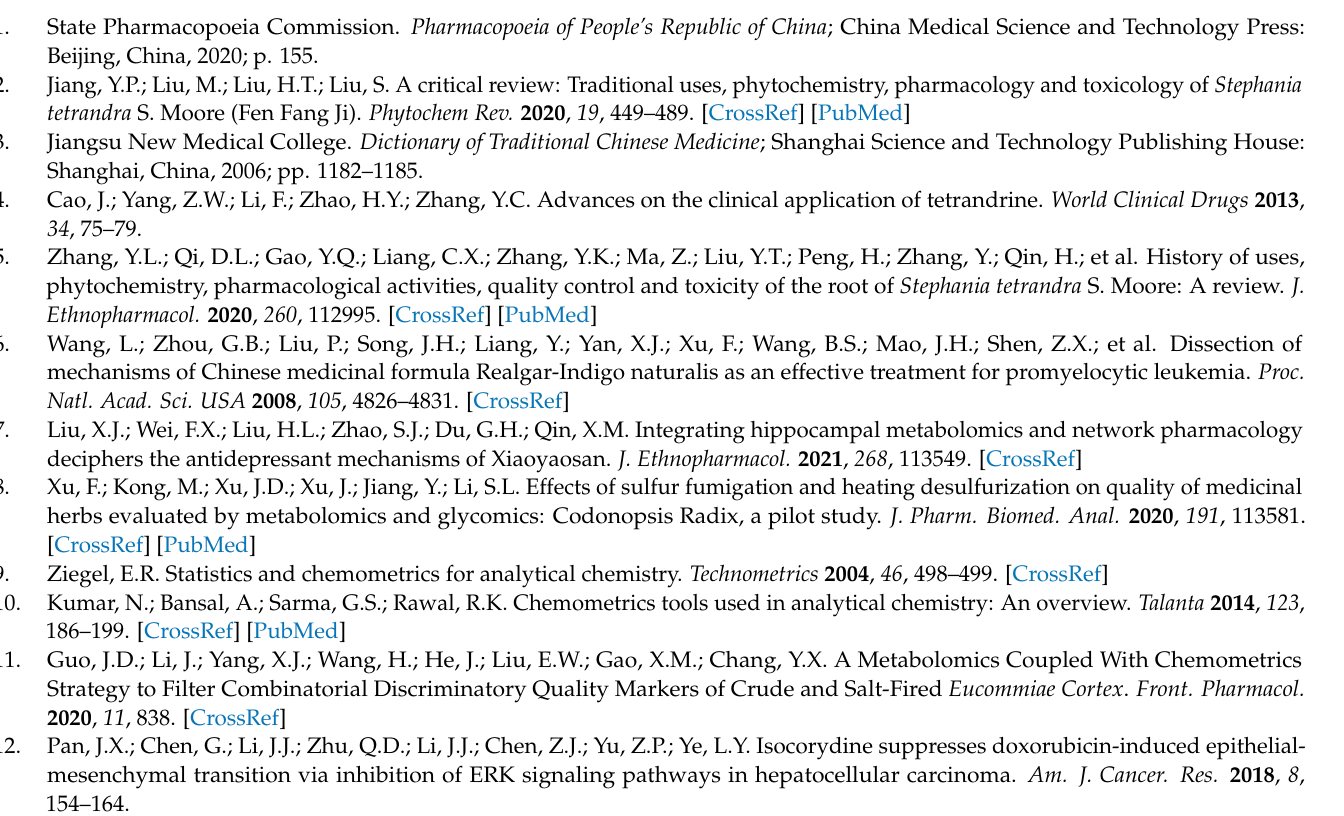
Figure S4: MRM chromatograms of higenamine (1), magnocurarine (2), boldine (3), magnoflorine (4), isocorydine (5), fangchinoline (6), tetrandrine (7). (A) standard solution; (B) S. tetrandra sample; Table S1: The RSDs of precision, repeatability, and stability in GC-MS and UHPLC-Q-TOF-MS/MS analysis; Table S2: Linear equation, linear range, correlation coefficients (r) and lower LOQ of seven alkaloids in UHPLC-MS/MS analysis (n = 6); Table S3: RSDs of precision, repeatability, and stability of seven alkaloids in UHPLC-MS/MS analysis (n = 6); Table S4: The results of recovery test of seven alkaloids in UHPLC-MS/MS analysis (n = 6); Table S5: Potential volatile markers responsible for differentiation of S. tetrandra from non-authentic and geo-authentic origins; Table S6: Differential nonvolatile compounds responsible for differentiation of S. tetrandra from non-authentic and